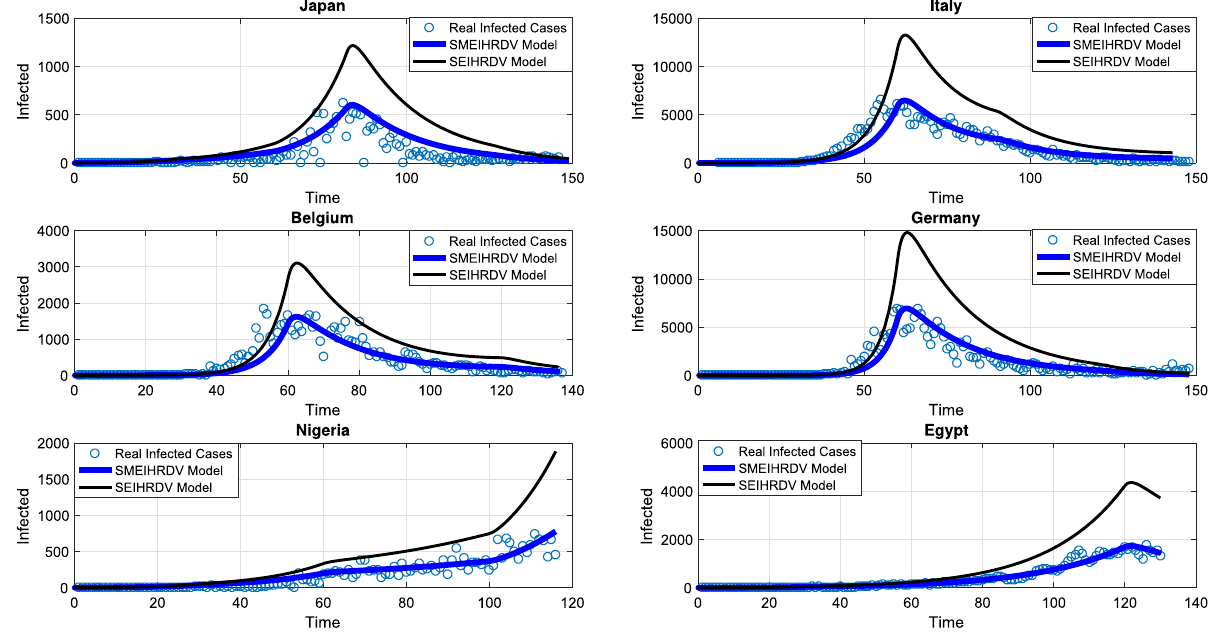
Figure 3. Fitting the models with real data. The number of infected individuals predicted by the “SEIHRDV” and the “SMEIHRDV” models for Japan (from 22th January to 23th June 2020), Italy (from 31th January to 23th June 2020), Belgium (from 4th February to 23th June 2020), Germany (from 27th January to 23th June 2020), Nigeria (from 28th February to 23th June 2020) and Egypt (from 14th February to 23th June 2020). The blue dots denote the reported infected cases and the black (or Less width) and blue lines present the results of the “SEIHRDV” and the “SMEIHRDV” models, respectively. The deSolve package version 1.28 27 in R software version 4.0.3 28 was used to generate the figure (http:// desol ve.r- forge. rproj ect. org/).